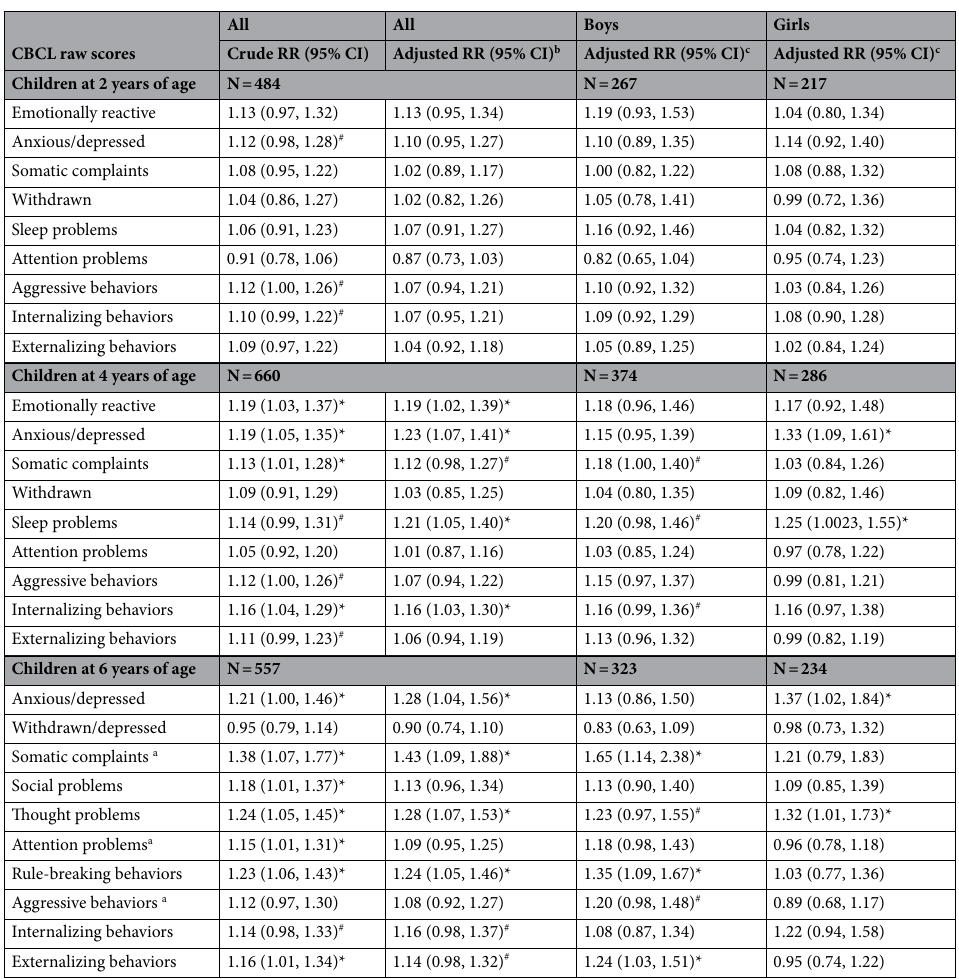
Table 2. Associations between preconceptional paternal alcohol consumption (yes/no) and CBCL raw scores for children at 2, 4 and 6 years of age. CBCL Child Behavior Checklist. *Statistically significant differences ( P -value < 0.05). # P- value < 0.10. a P -values of interaction item (preconceptional paternal